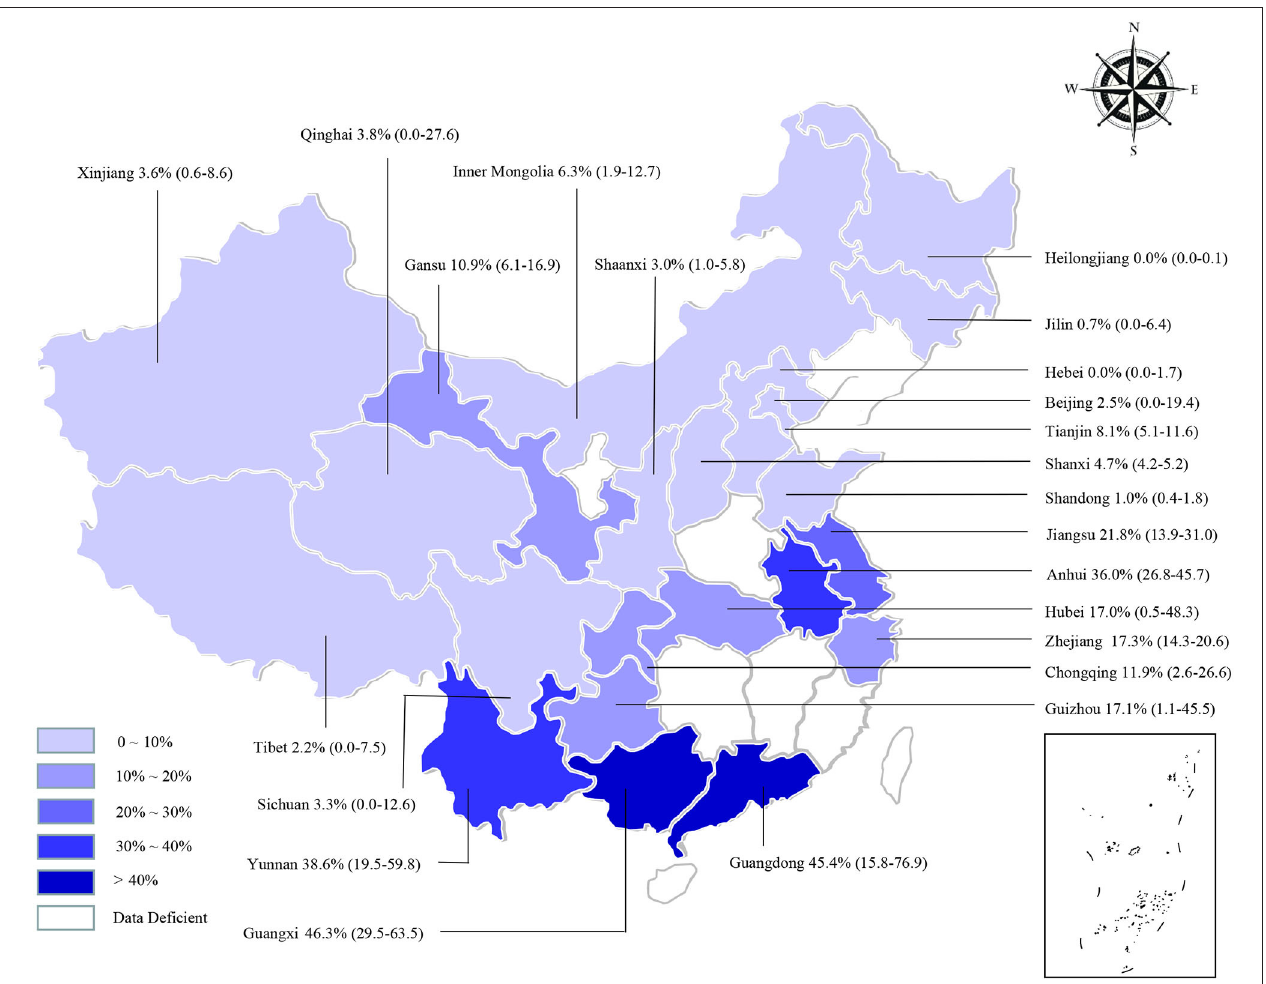
FIGURE 2 | Bluetongue virus infection in cattle in China. Different saturations in the HSB slider represent different infection rates.